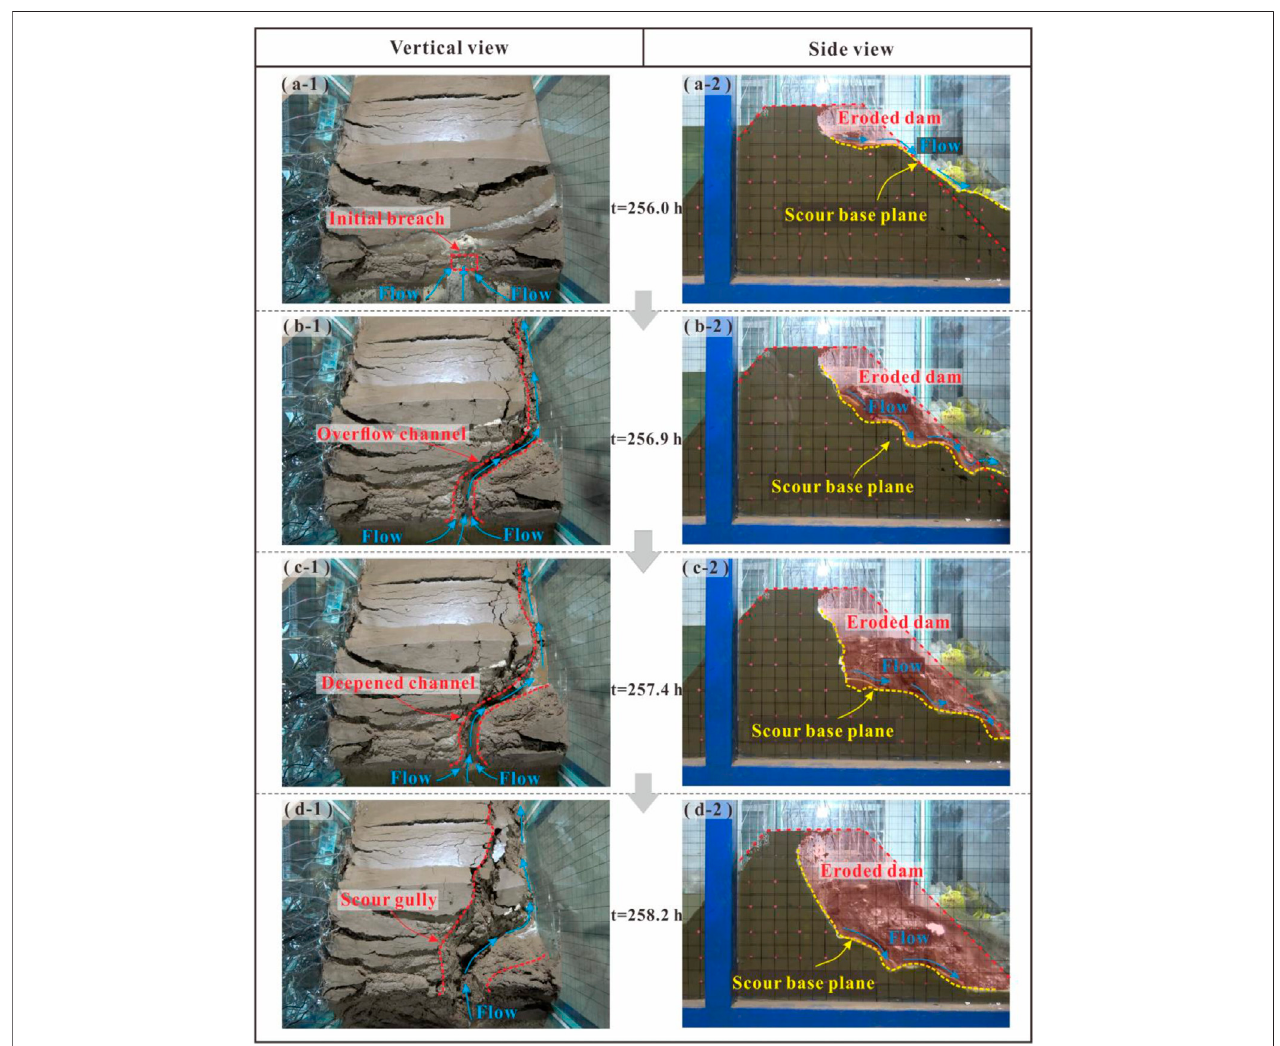
FIGURE 13 | Progressive process of overtopping from vertical view and side